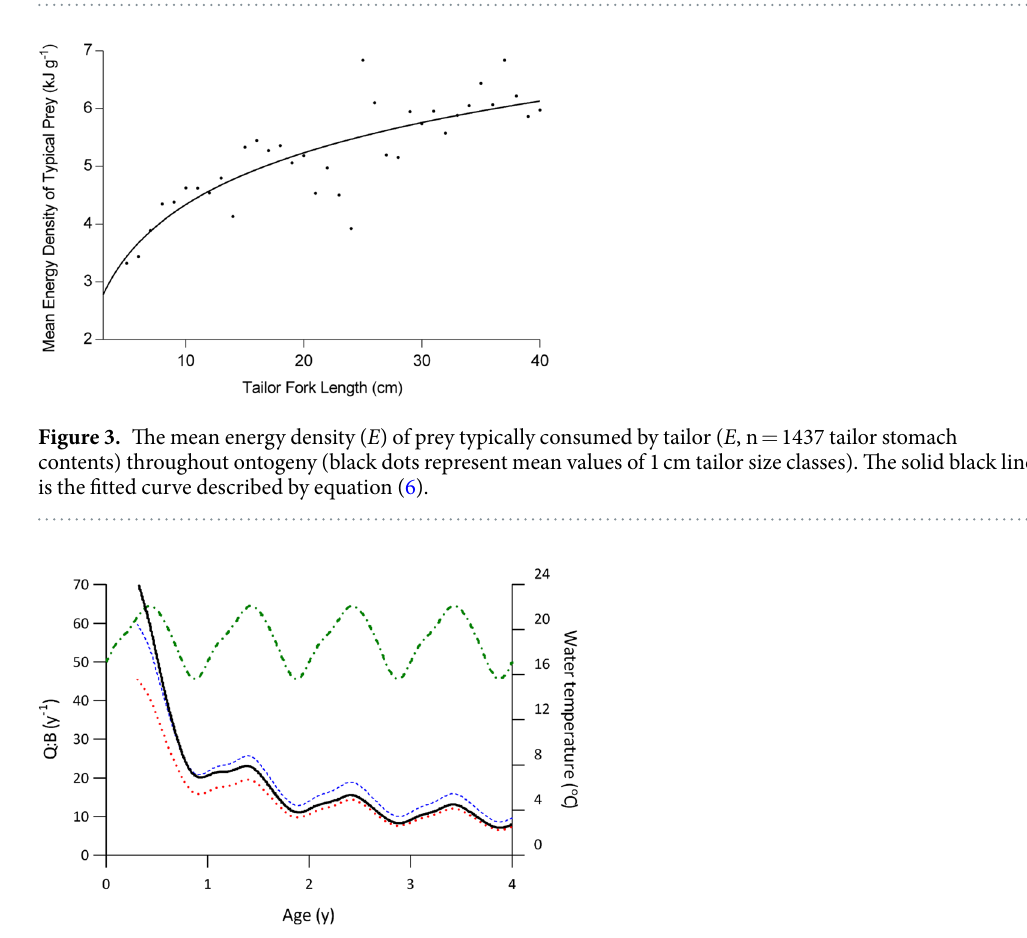
Figure 2. The proportion of common prey types consumed by tailor throughout their ontogeny n = 1437; adapted from 27 . The “Other Fish” category contains ~30 species of teleosts.